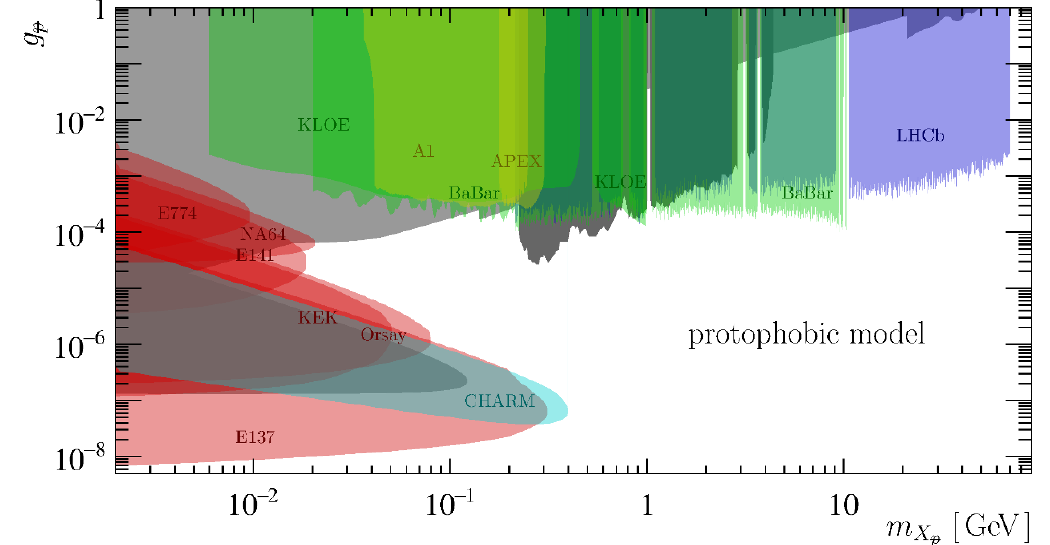
Figure 7 . Constraints derived on visible protophobic decays using the same experimental color scheme as in (cid:12)gure 4. The grey constraints are from the same processes as in (cid:12)gure 6, but recast to the protophobic model as part of this study.